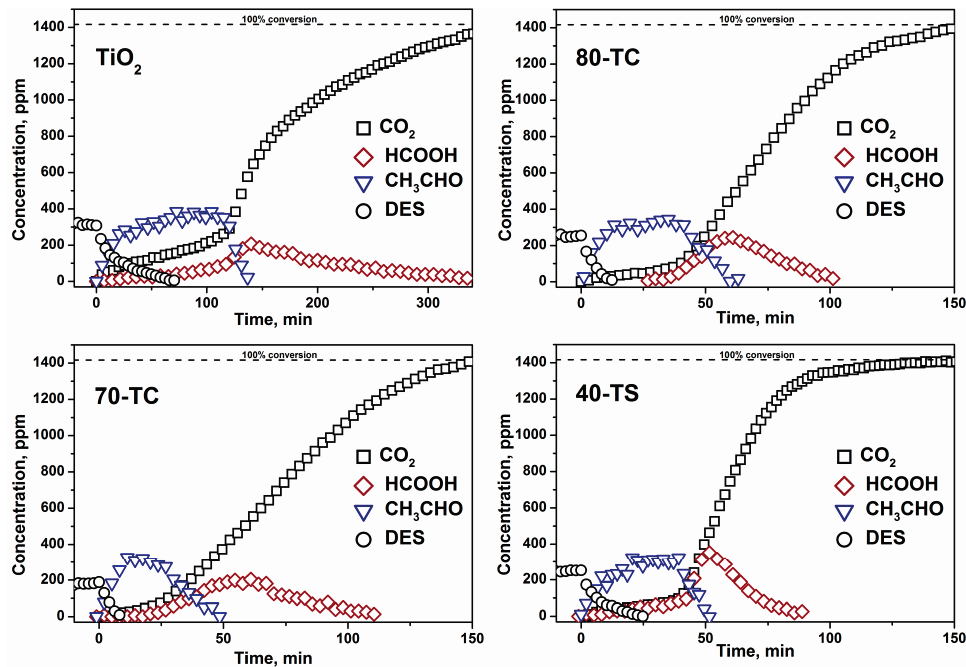
pure TiO 2 , 80-TC, 70-TC and 40-TS samples.